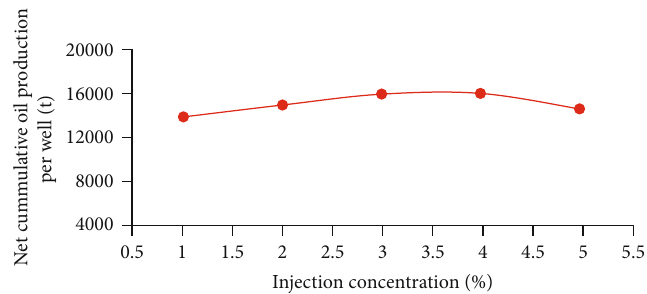
Figure 9: Relationship between net oil cumulative production and viscosity reducer concentration for a single well.